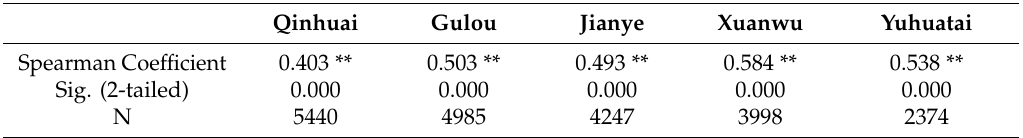
Table 6. Spearman correlations between the GVI and Normalized Di ff erence Vegetation Index (NDVI) in each urban district. Table 7. Spearman correlations between the GVI and NDVI in the main city and each UFZ. Urban Commercial Area